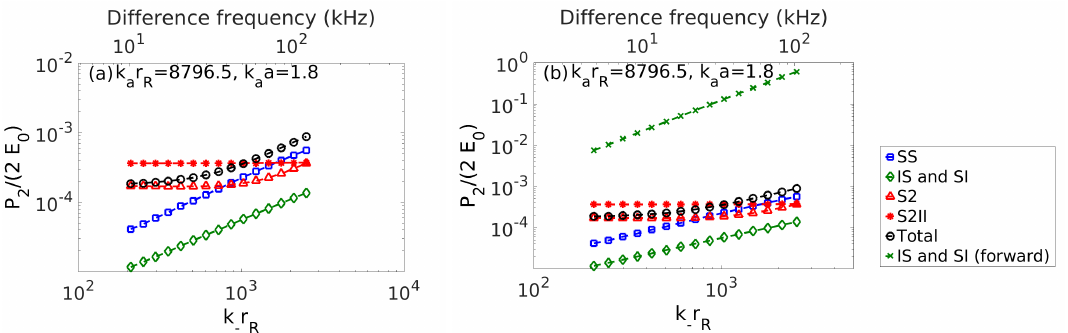
Figure 9. ( a ) A near surface air bubble in water with collinear incident waves propagating at ˆ i z . The difference frequency component of p 2 is calculated in backscatter at r R = − r R ˆ i z as a function of difference frequency or k − r R . Lower dimensionless abscissas are for general interpretations. Upper abscissas are for 430 kHz primary and 43 kHz difference frequencies with bubble radius 0.1 mm radius at 4.88 m range from the receiver in water. A transition between mechanisms is seen where p SS is dominant for k − a > 1 while p S2 is dominant for k − a (cid:28) 1 above and near resonance. The nonlinear parameter is β = 3.6. ( b ) Same as ( a ) but with p IS + p SI in the forward direction also included for r R = r R ˆ i z which is seen to dominate the field over the entire range